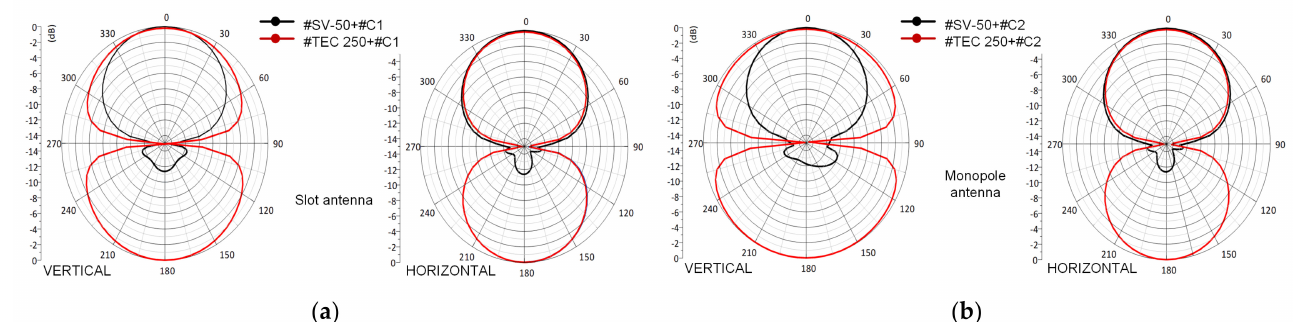
Figure 23. Vertical and horizontal directional diagrams (f 0 = 866 MHz): ( a ) Slot antenna #C1; ( b ) Monopole antenna